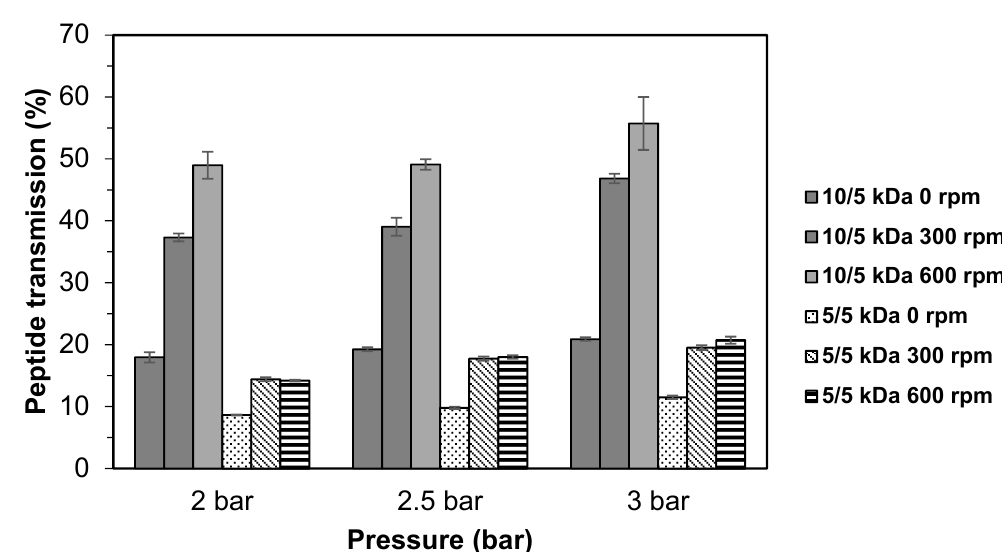
Figure 3. Peptide transmission of TB protein hydrolysate through multilayer UF membranes at different stirring speeds.